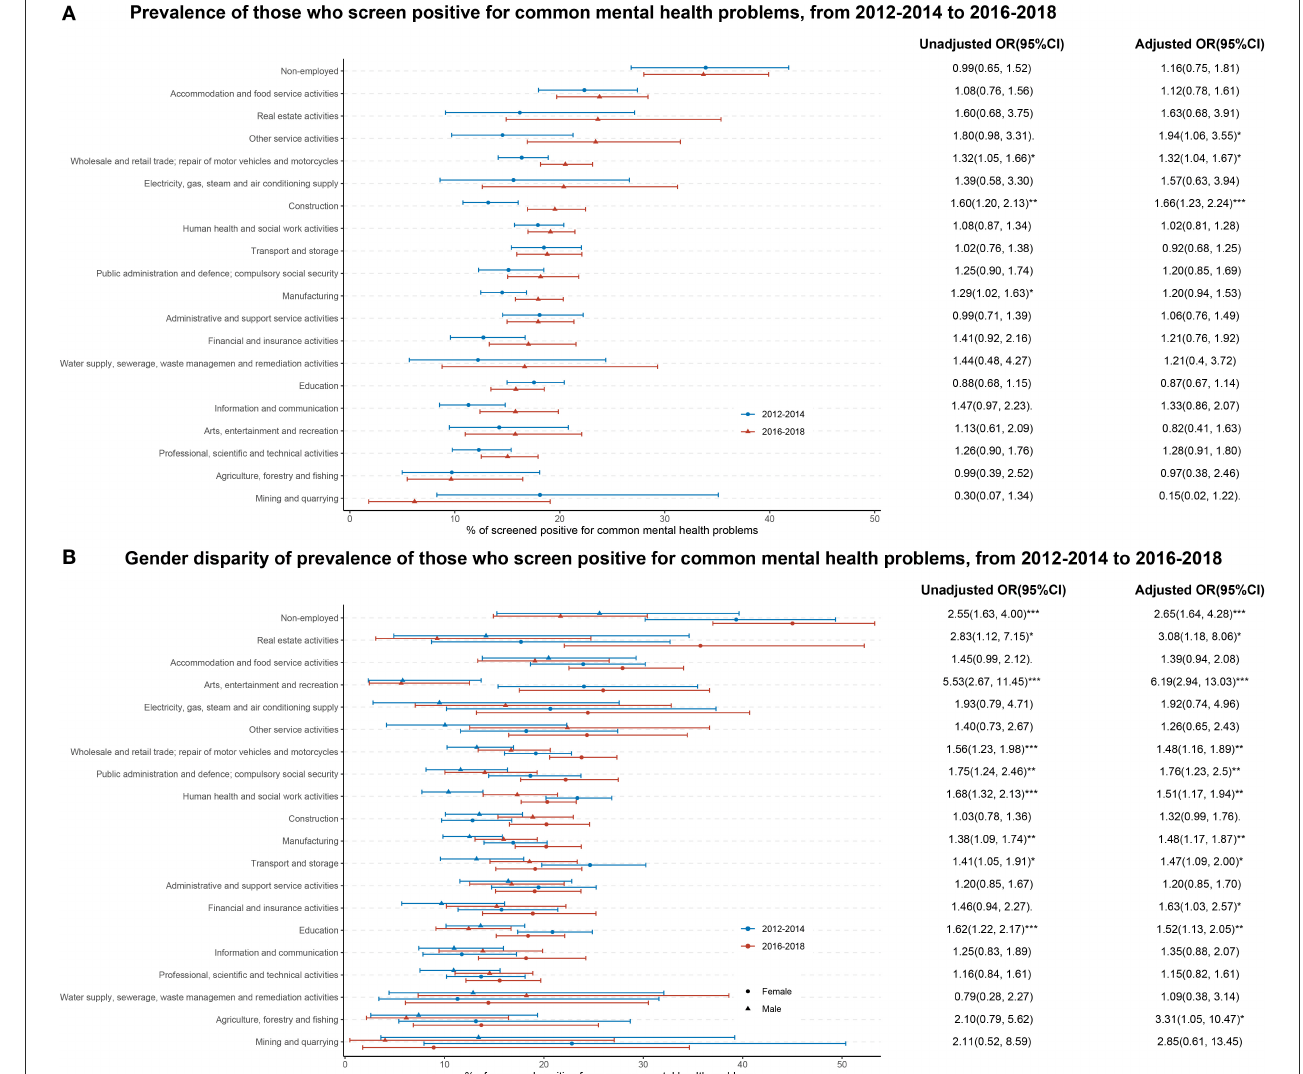
the industry of transport and storage (AOR for trend = 0.5, 95%